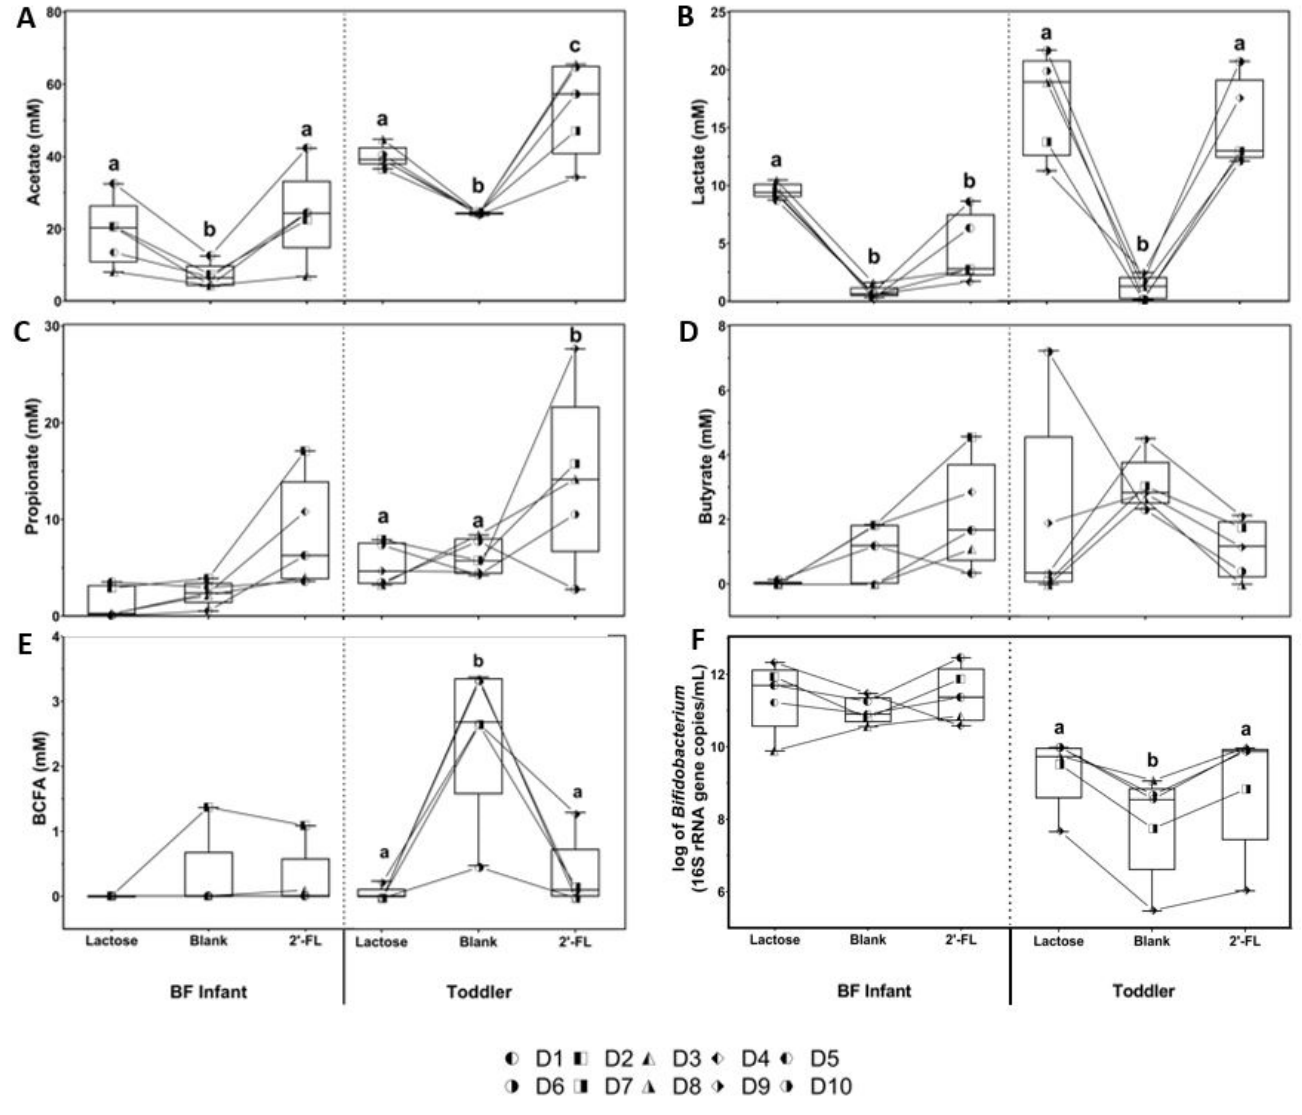
Figure 3. Effect of lactose or 2’-FL on bacterial metabolites and Bifidobacterium levels in short-term colonic incubations. Bars represent changes in ( A ) acetate, ( B ) lactate, ( C ) propionate, ( D ) butyrate, ( E ) BCFA, and ( F ) Bifidobacterium levels during short-term fecal batch incubations (0–48 h) for five breastfed (BF) infants (D1, D2, D3, D4, and D5) and five toddlers (D6, D7, D8, D9, and D10), upon treatment with lactose or 2’-FL versus a blank control ( n = 5, 1 each from 5 individual donors). BF = breastfed; 2’-FL = 2’fucosyllactose; D = donor; BCFA = branched-chain fatty acids; SCFA = short-chain fatty acids. Significant differences between the average control and the two treatments per age group, as tested with a two-way ANOVA with Bonferroni correction, are indicated with different letters (a, b, c; p <0.05).